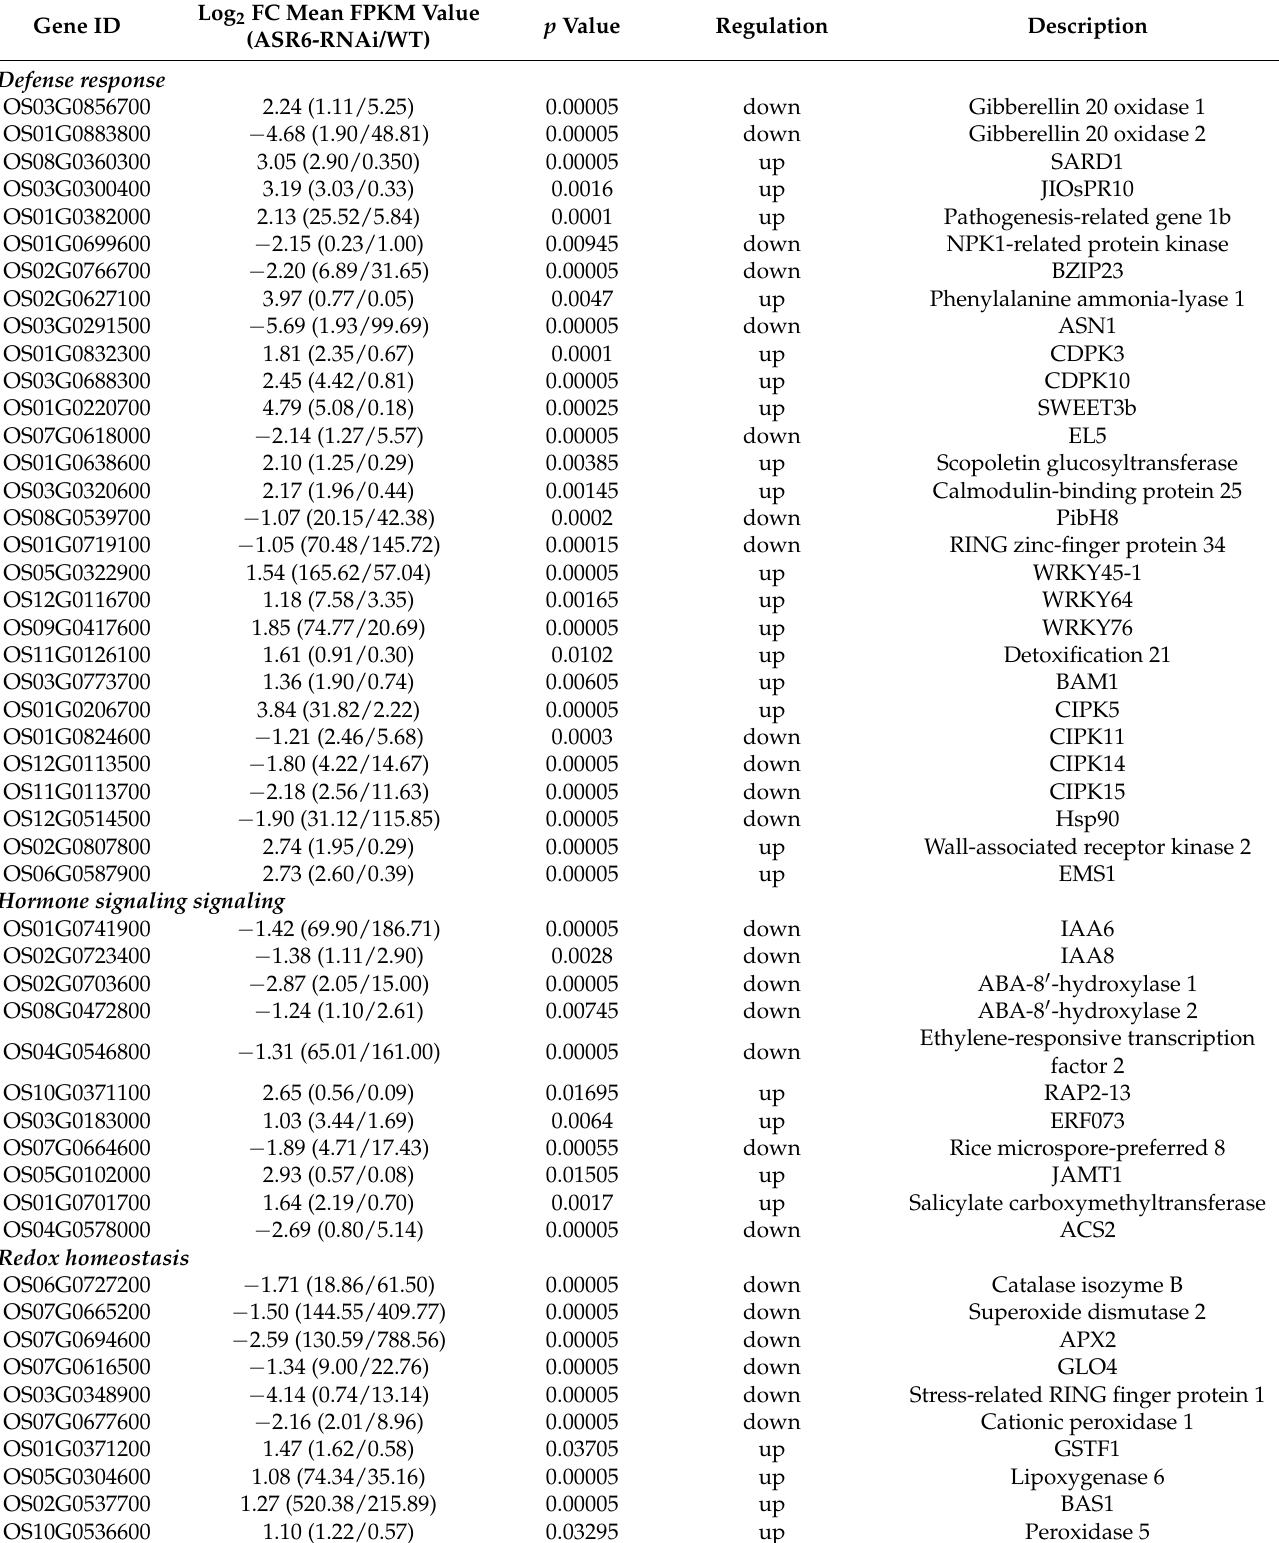
Table 2. Potential constitutive targets of OsASR6 function in suppressing rice